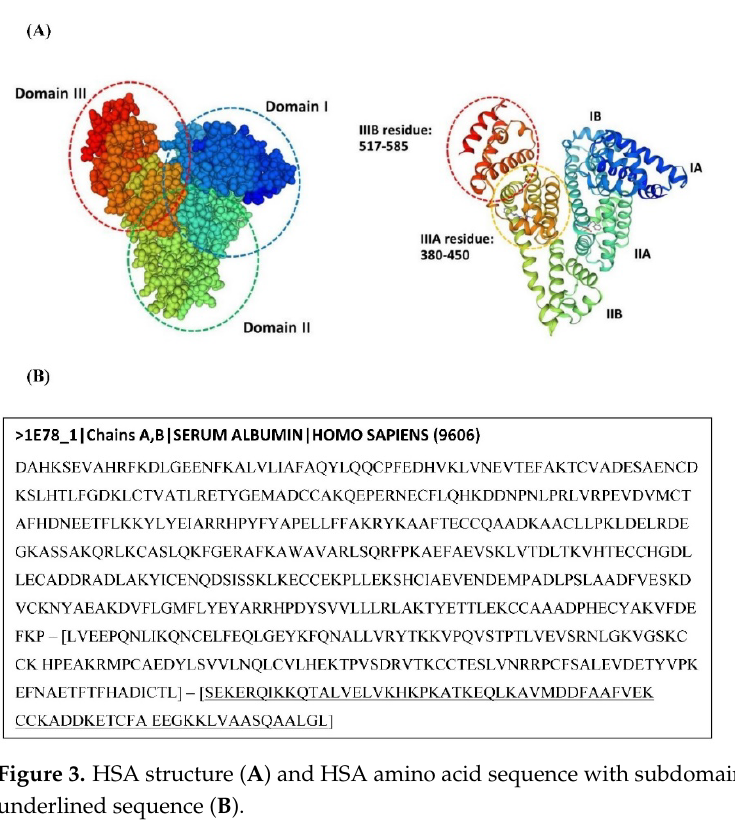
Figure 3. HSA structure ( A ) and HSA amino acid sequence with subdomain IIIB showing under the underlined sequence ( B ).